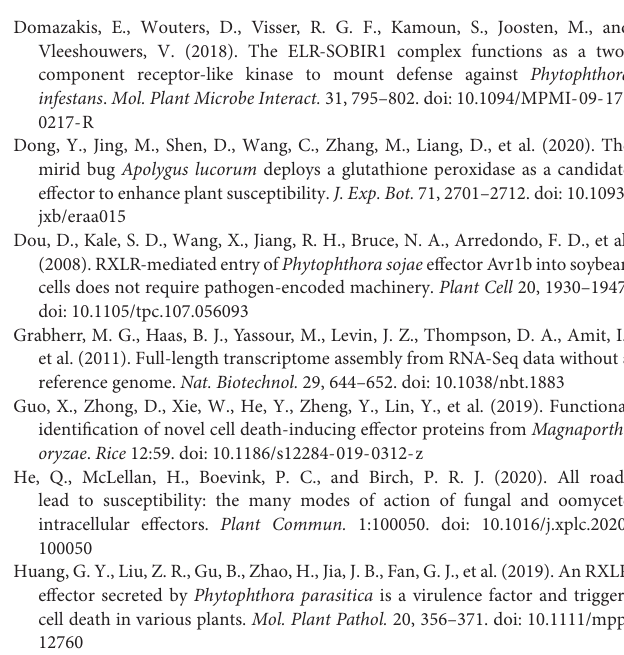
( Figure 8 ). We suspect that RP309 is a specific reservation from the coevolution of R. pedestris and its